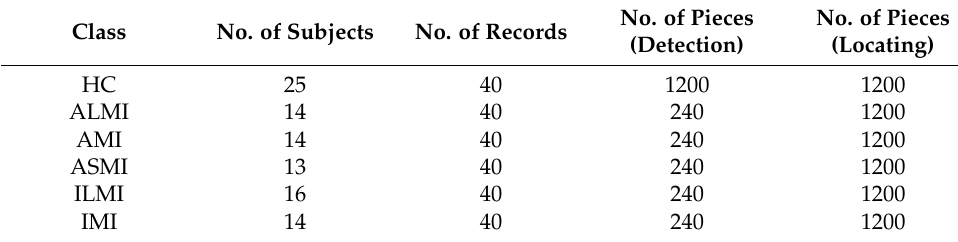
Table 1. Patient and data distribution after